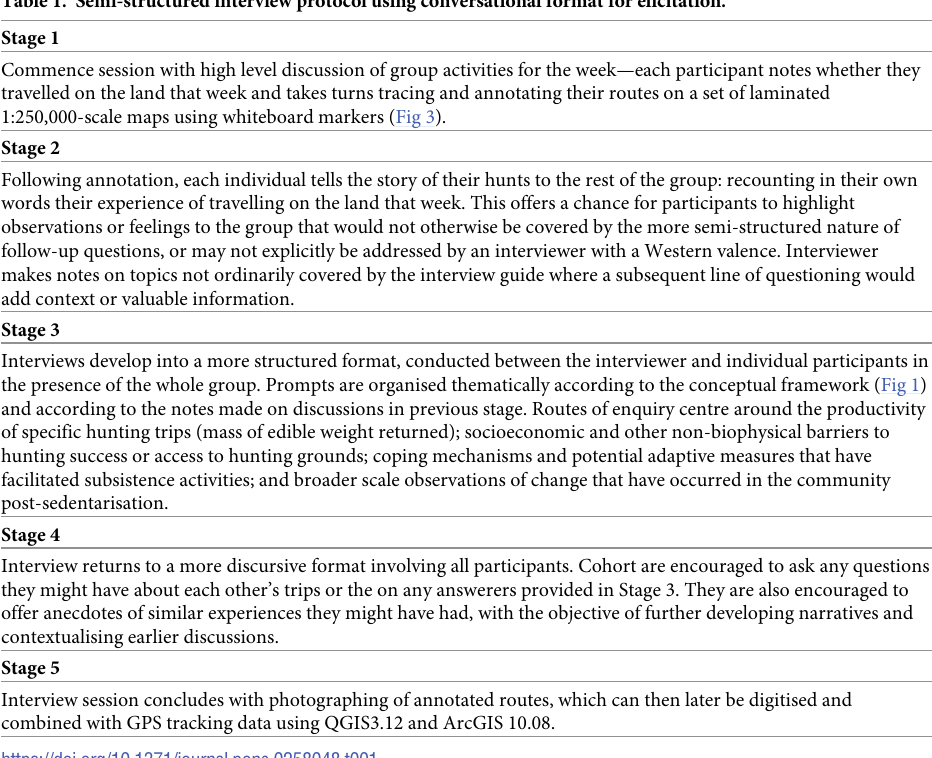
Table 1. Semi-structured interview protocol using conversational format for